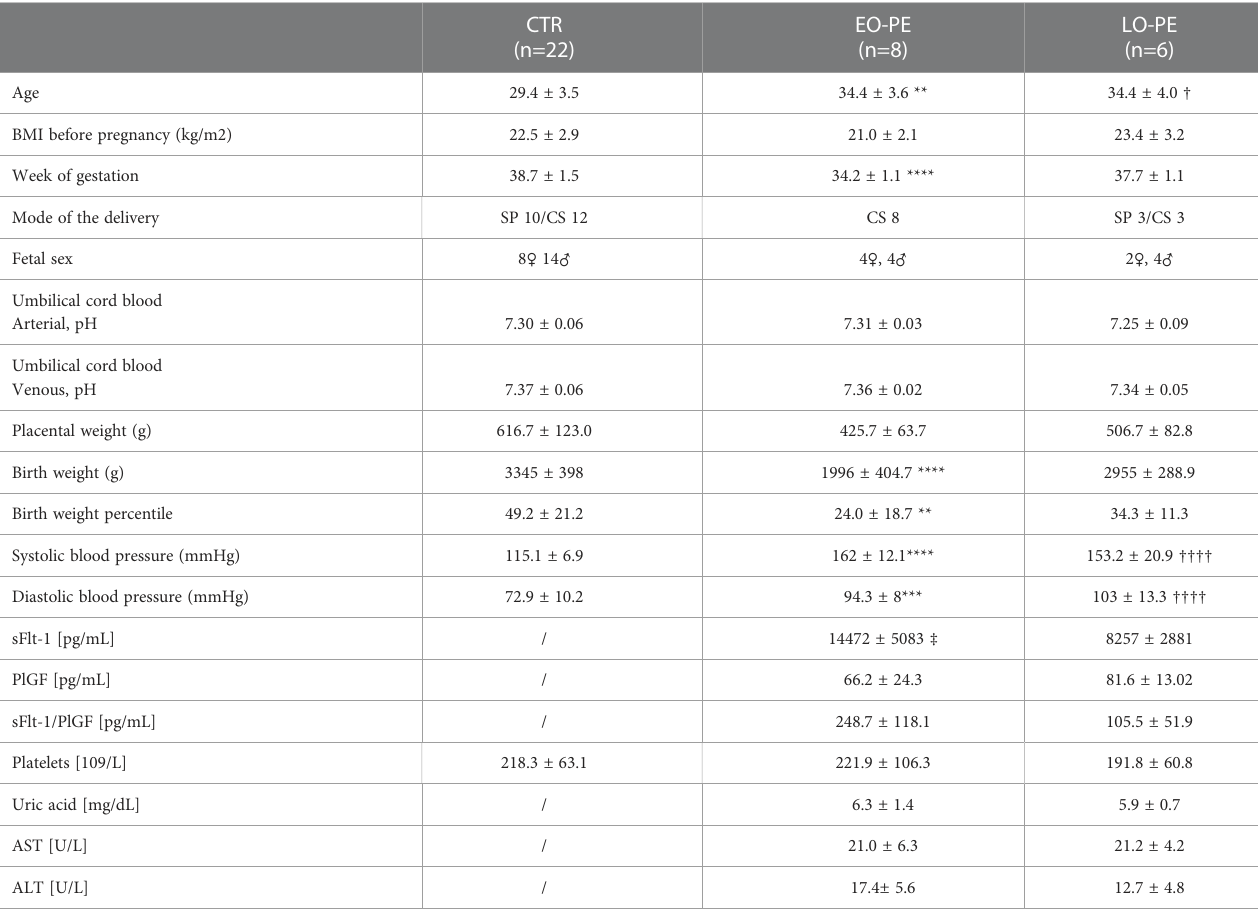
TABLE 1 Subject characteristics of women and their offspring included in the